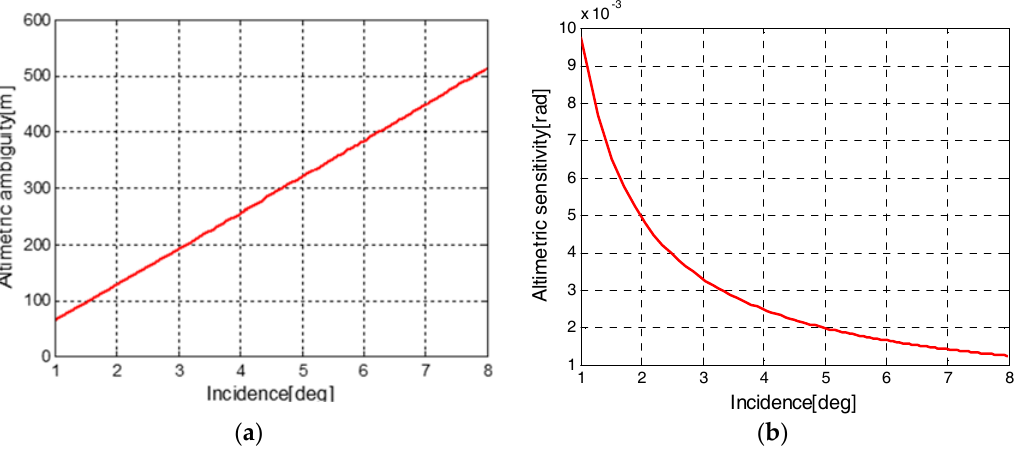
Figure 4. ( a ) Altimetric ambiguity of InIRA corresponds to a phase ambiguity of 2 π ; ( b ) Altimetric sensitivity of InIRA corresponds to a 10 ‐ cm ocean surface height change.